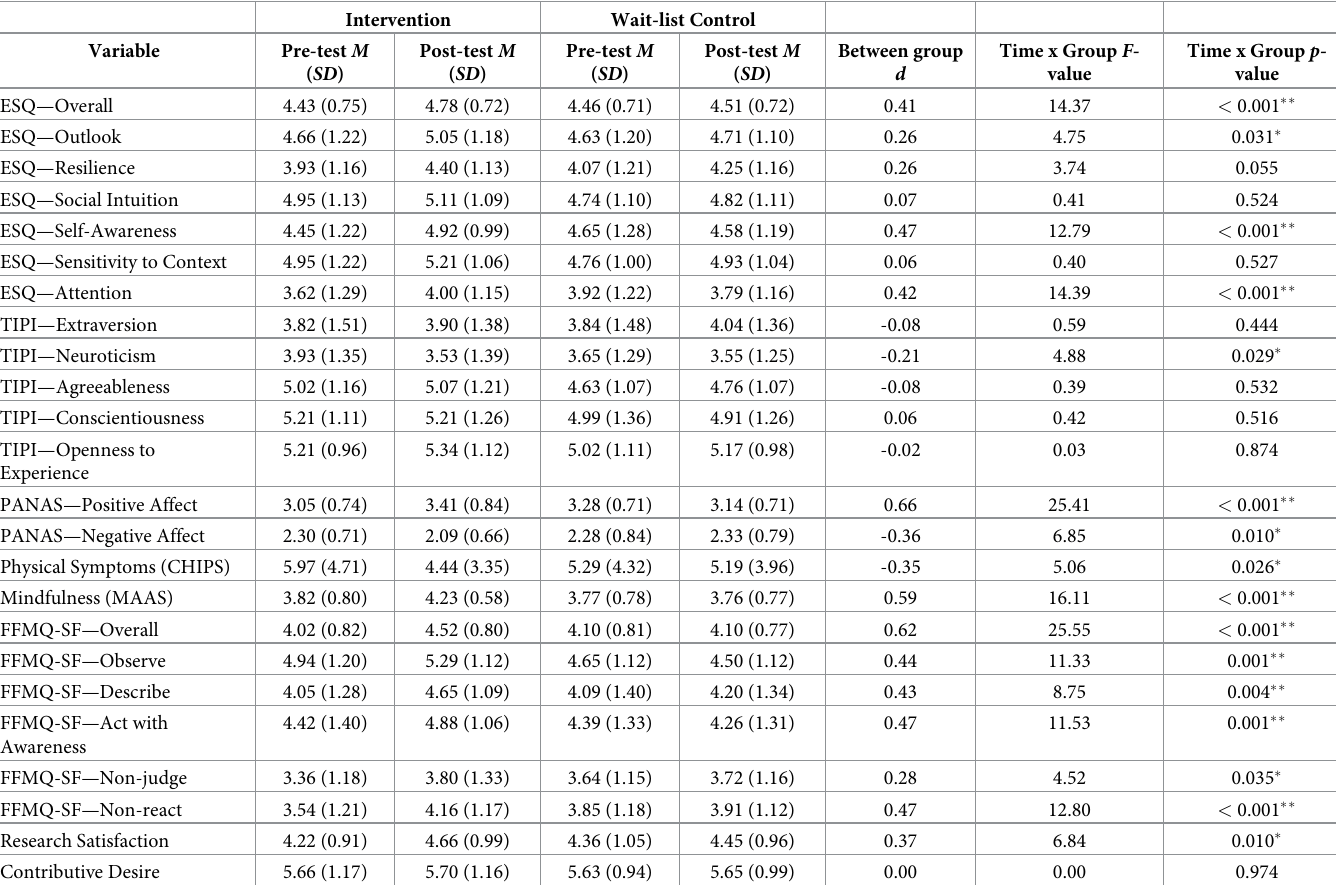
Table 2. Phase 2 pre- and post-test Means ( M ), Standard Deviations ( SD ), between group effect sizes ( d ), and RMANOVA results ( F -value, p -value) for intervention and control groups (Year 1 and Year 2